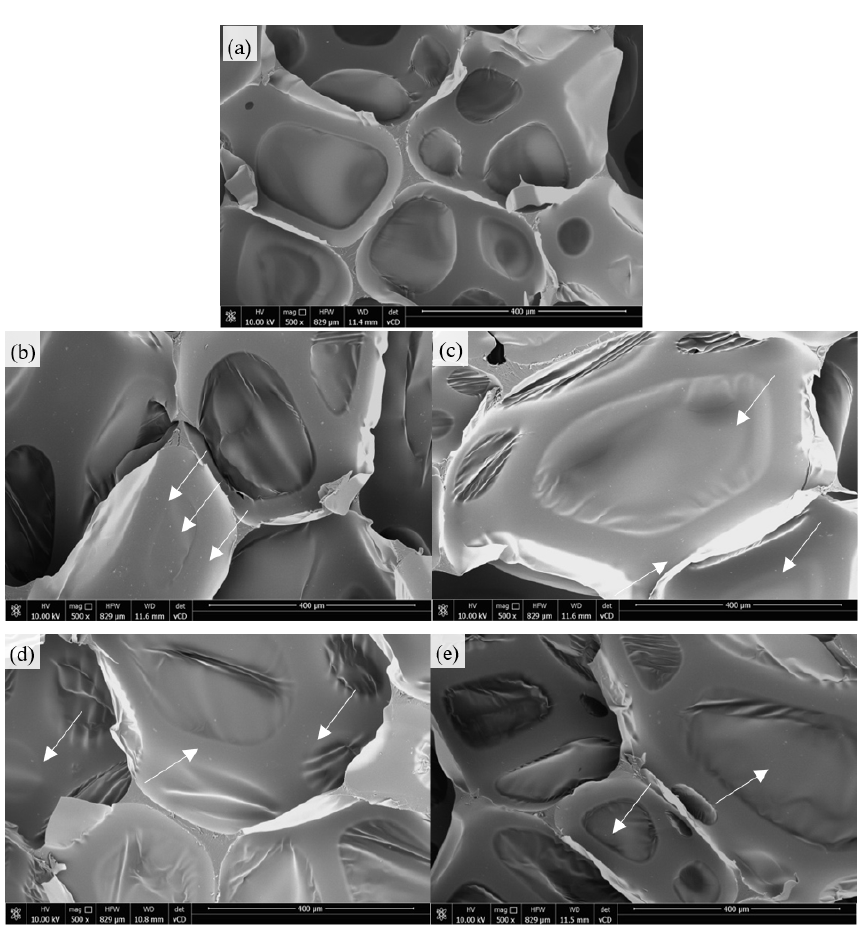
Figure 4. SEM images of ( a ) PU_0, ( b ) PU_V, ( c ) PU_VC, ( d ) PU_VCH, ( e ) PU_VPP.